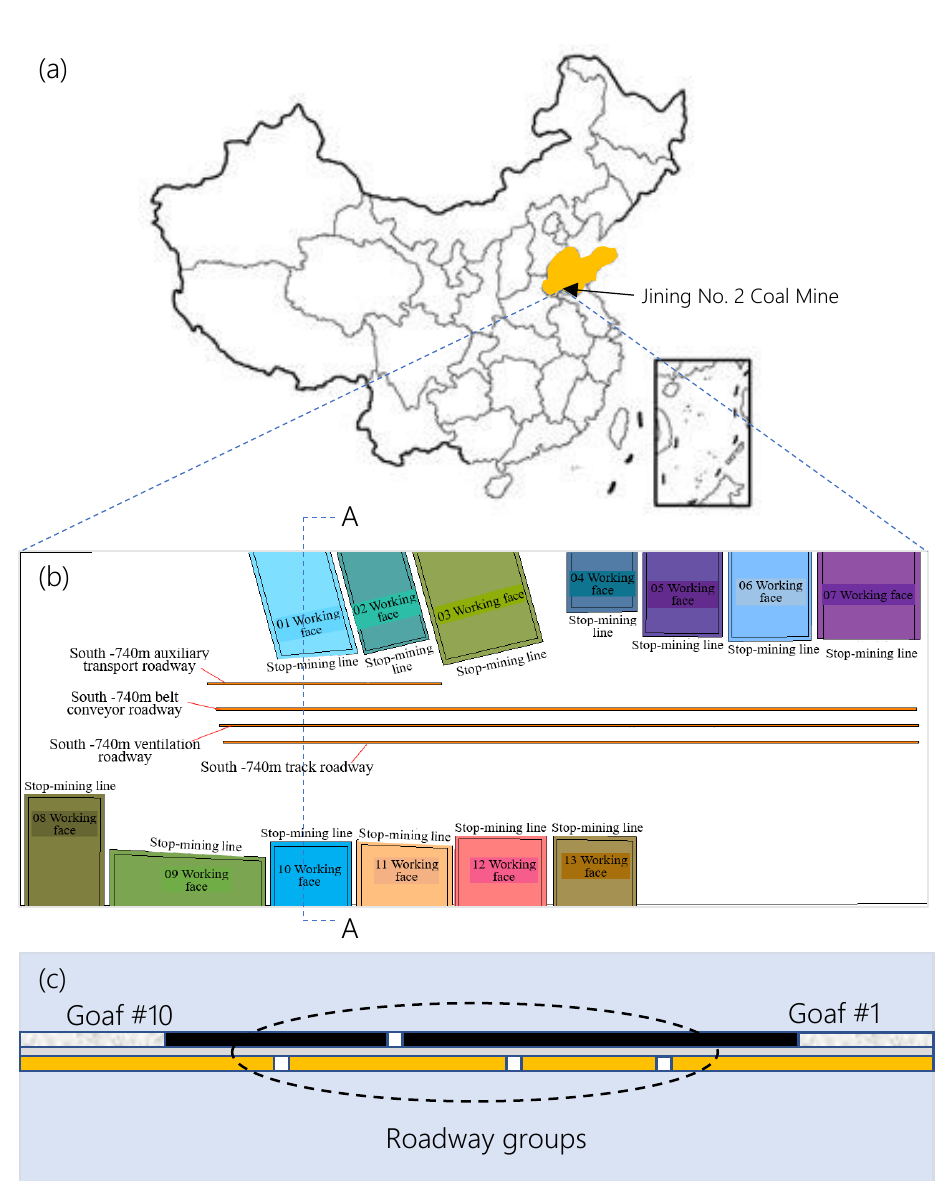
Figure 1. Locations. ( a ) Jining No. 2 Coal Mine ( b ) roadway and working face. ( c ) Cross-section of A-A.